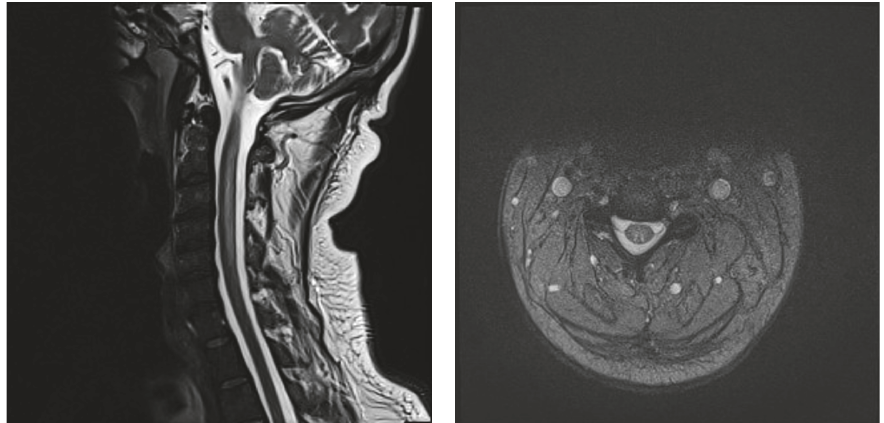
Figure 2: T2 weighted MRI in both axial and sagittal views of the spine shows long segment of abnormal high signal involving the posterior aspect of the cervical cord extending from C1 to